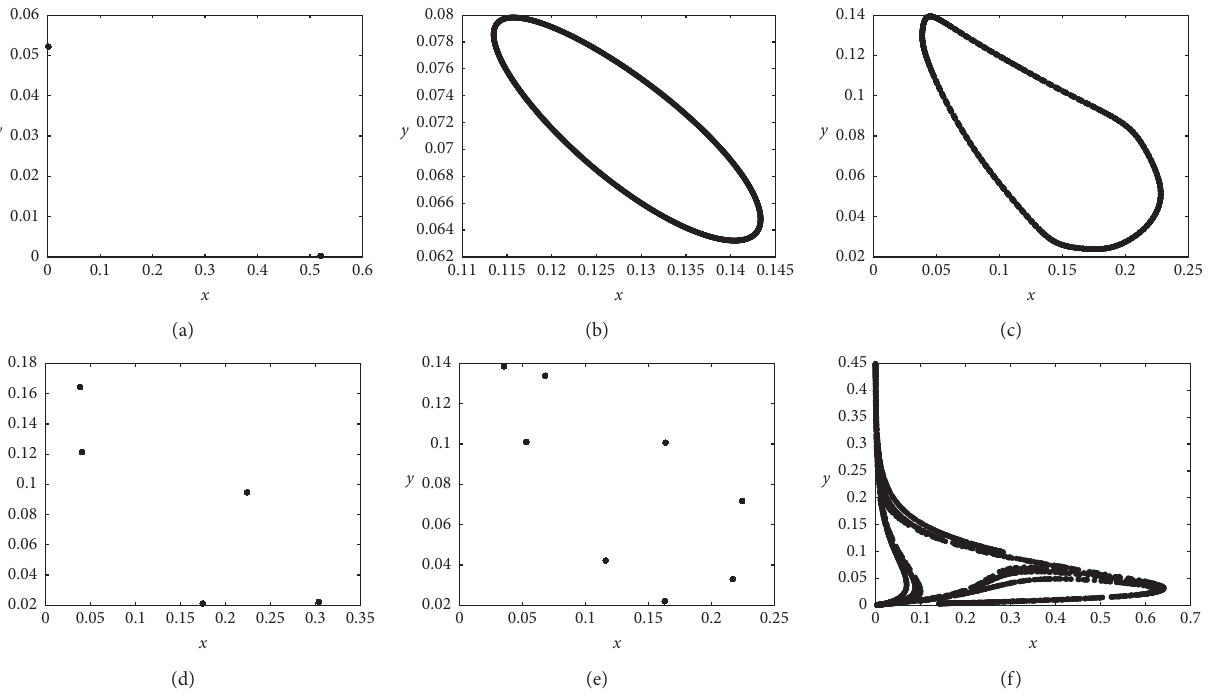
Figure 5: The phase diagrams of equation (3) ((a) 0.03 < b < 0.435, (b-c) 0.5526 < a < 0.61, (d) 0.565 < b < 0.57, (e) 0.615 < b < 0.619, (f) b > 0.68).